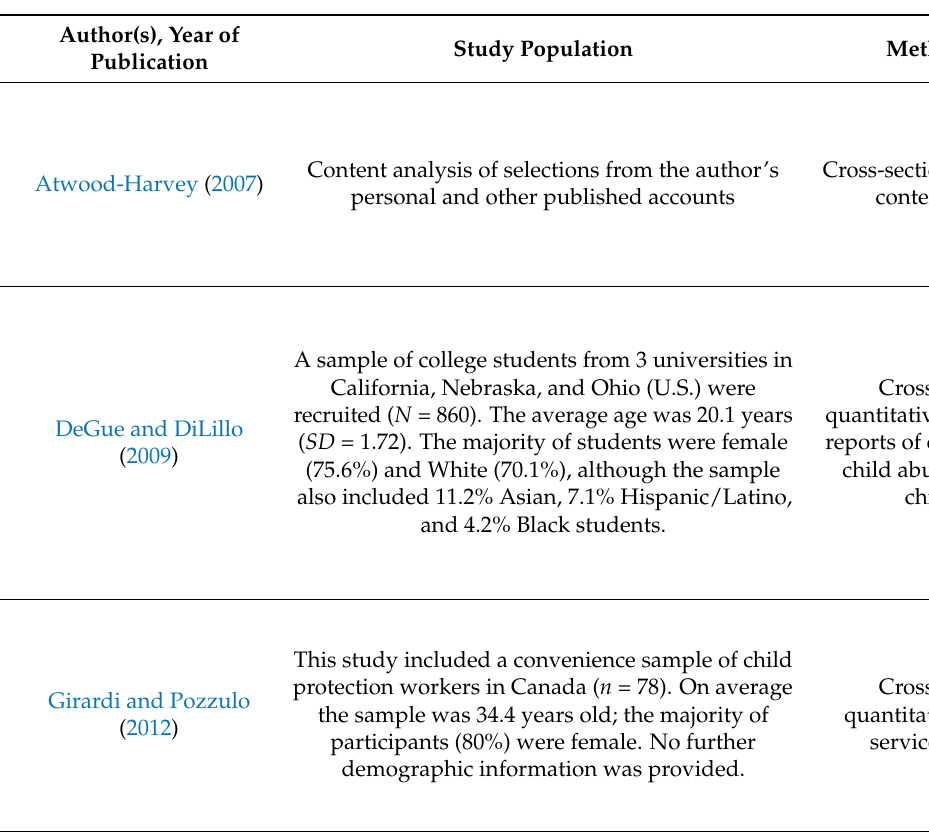
Table 5. Studies Included in the Scoping Review That Examined Child Maltreatment and Animal